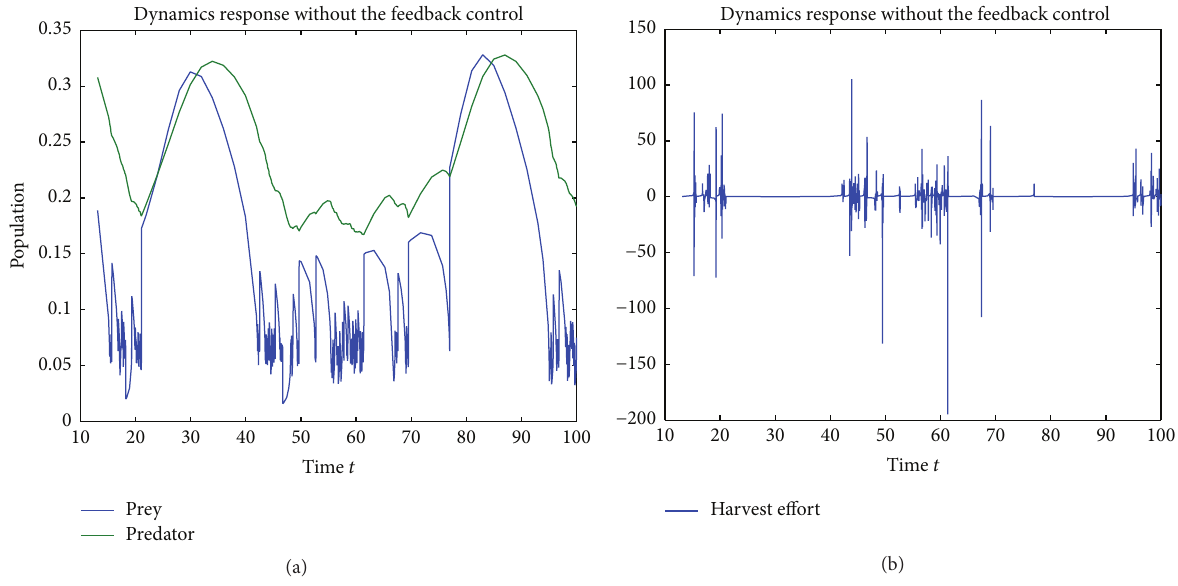
Figure 1: The dynamical responses of system (13) without feedback control.